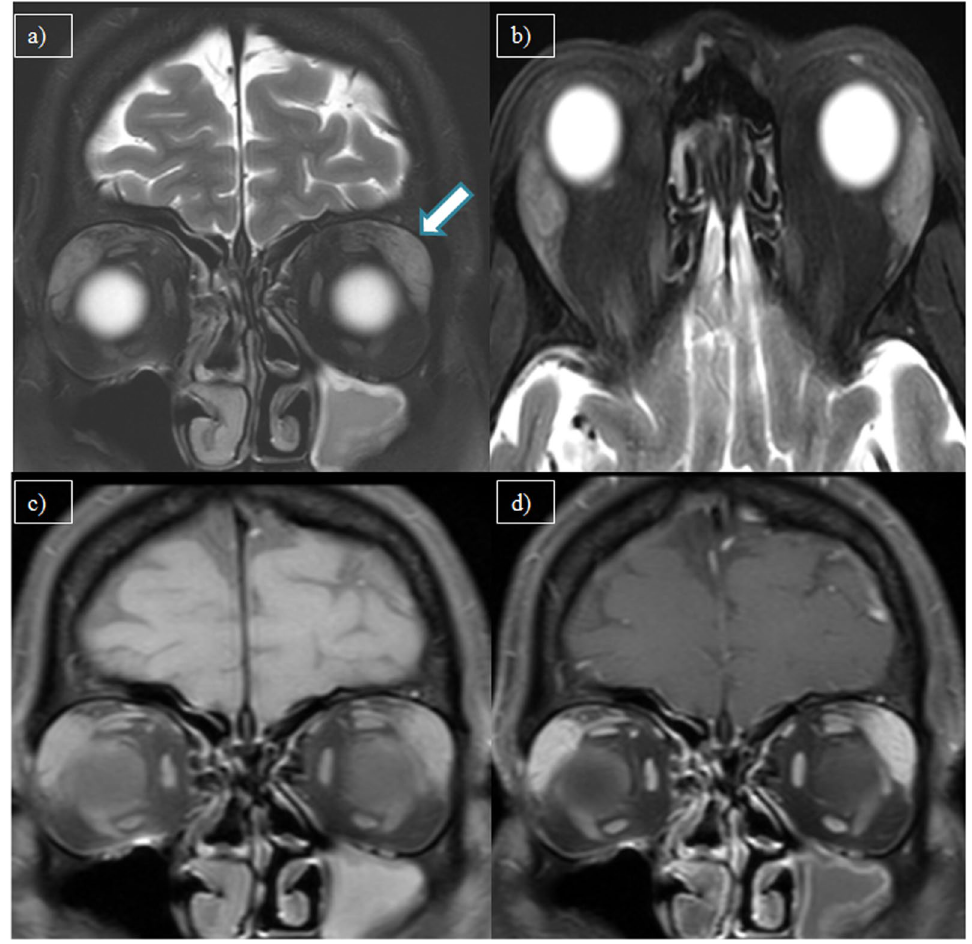
Fig. 8 a MRI coronal T2W-FS, b axial T2W-FS, c coronal pre-contrast T1W-FS, and d coronal post-contrast T1W-FS images of a 49-year-old male patient with complaints of headache showing bilateral symmetrical enlargement of lacrimal gland appearing hyperintense on T2W (arrow) and showing homogenous post-contrast